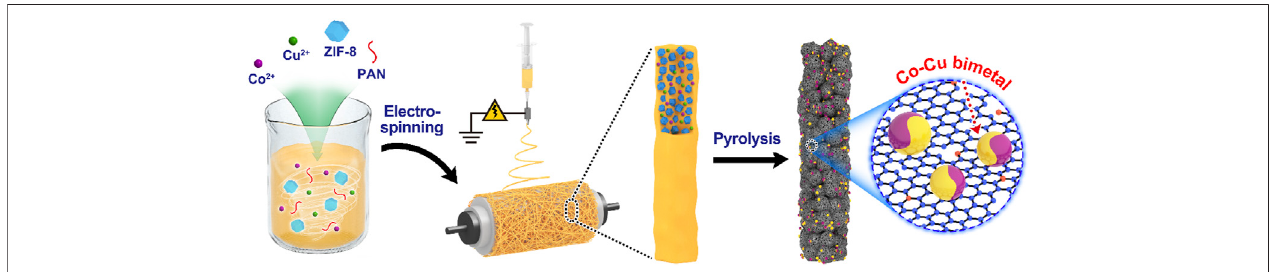
(F) HR-TEM images of Co 3 Cu/CFs, respectively; 3 Cu/CFs: inset shows the lattice